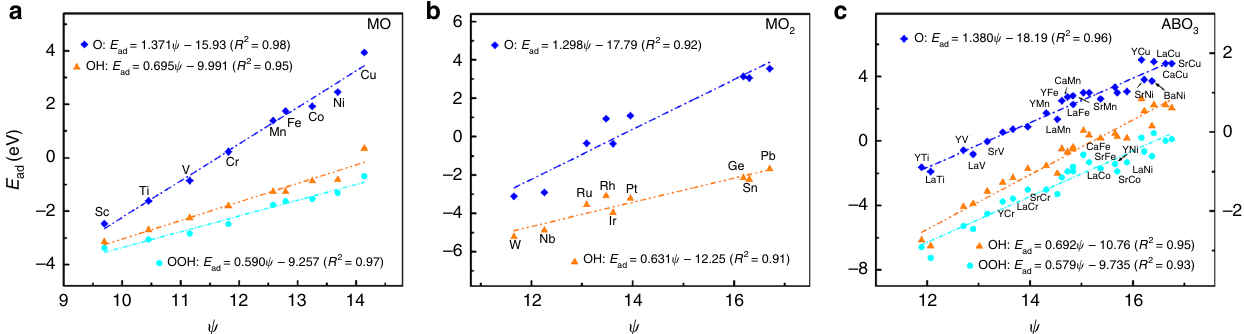
Fig. 5 Adsorption energies of small molecules on oxides as a function of the electronic descriptor ψ . a – c OH x and OOH on (100) surface of monoxides MO(100) 37 ( a ), (110) surface of dioxides MO 2 (110) 40 ( b ), and (100) surface of perovskite oxides ABO 3 (100) 37 ( c ). In each panel, the adsorption energies of adsorbates are linearly correlated with the electronic descriptor ψ . The adsorbate name, the color code, and the linear fi ts are provided as insets and the corresponding parameters are summarized in Supplementary Table 13. In each sub fi gure with both the left and right axes, the linear fi ts at the upper left corner correspond to the left coordinate axis and those at the bottom right corner correspond to the right coordinate axis. Clearly, the adsorption energy scales linearly with ψ , whereas the slope k is governed by electron-counting rules and can be described by the unsaturated bond number of the central atom in adsorbates. Source data are provided as a Source Data fi le.